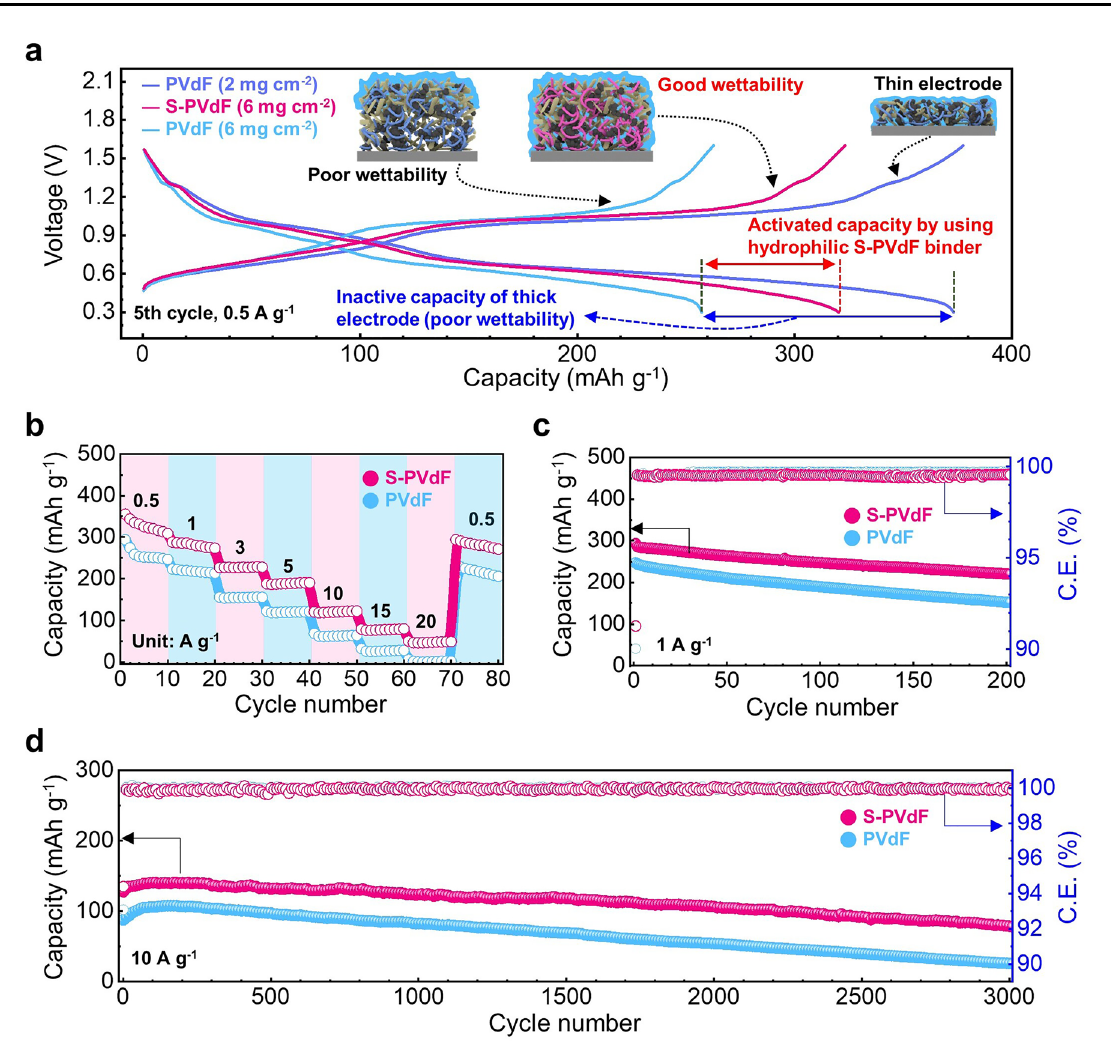
Fig. 4 a Galvanostatic charge/discharge voltage profiles voltage versus specific capacity at a current density of 0.5 A g −1 (the 5th cycle). b Rate capability and c cycling performances at a current density of 1 A g −1 . d Long-term cycling performances of full cells with different binders at a current density of 10 A g.